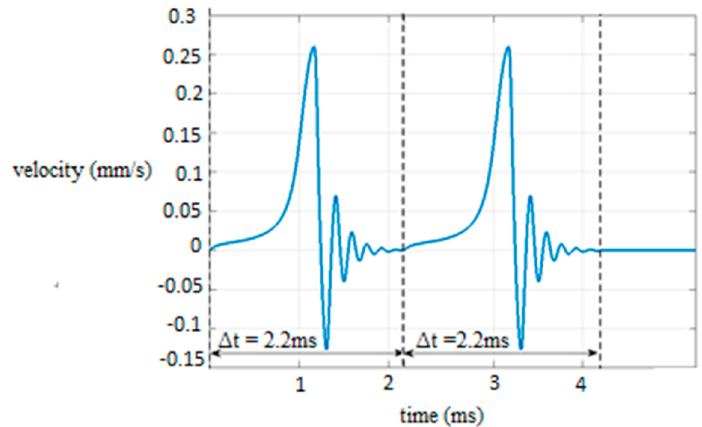
Figure 9. Graph of the velocity of the micropart with respect to time for the displacement of the COM of the micropart after two activations of the “Smart Platform”.